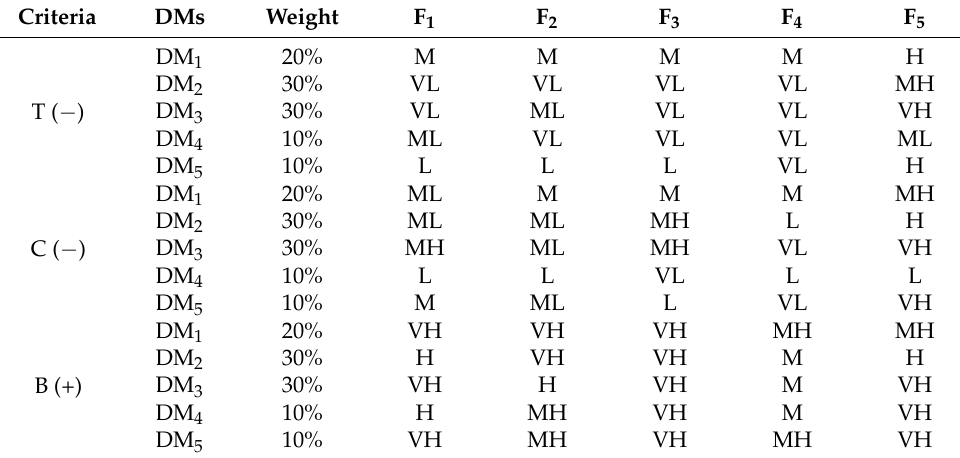
Table 6. The results of the three risk factors for vehicle failure modes.